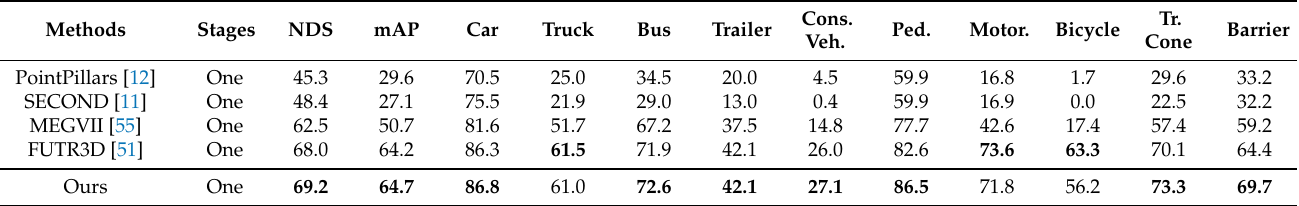
Table 7. Comparison with state-of-the-art methods on the nuScenes validation dataset. The results of PointPillars, SECOND and FUTR3D are reproduced with their official